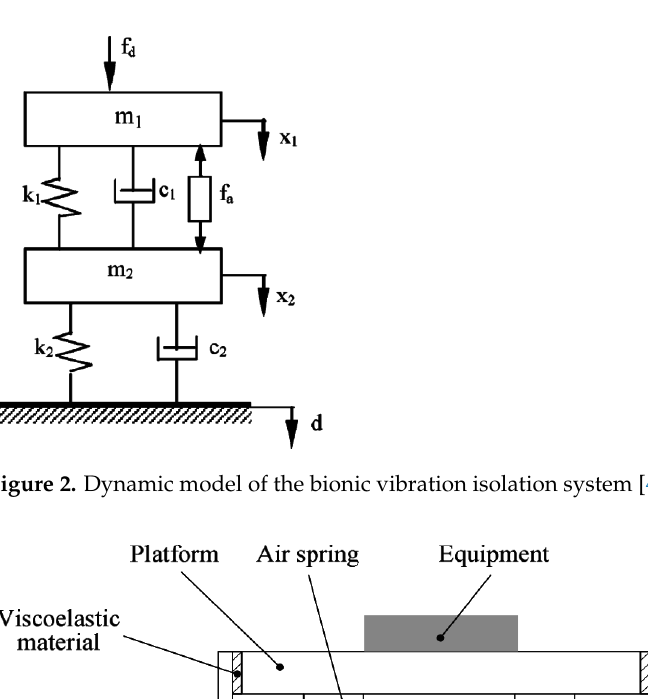
Figure 1. Schematic diagram of woodpecker’s head structure ( a ) and bionic active vibration isolation platform ( b ) [42].